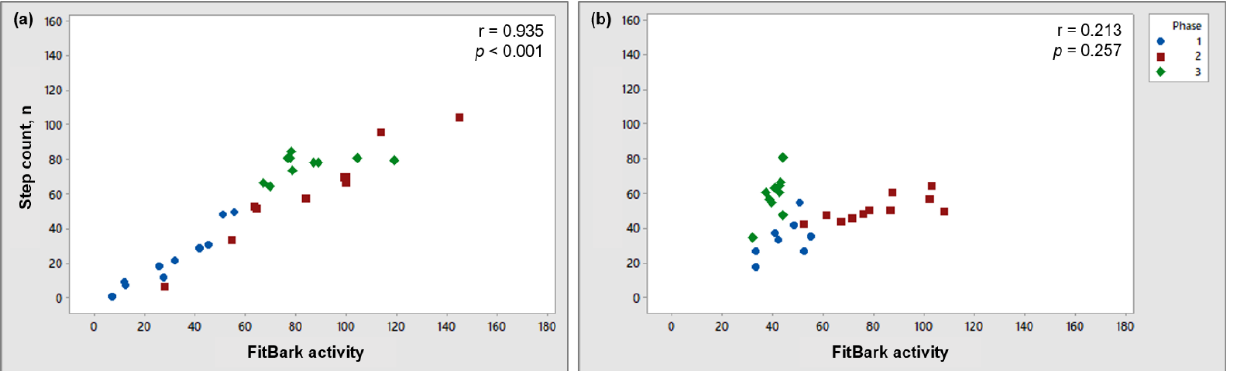
Figure 3. Plot showing the relationship between step count and activity recorded by a FitBark 2 monitor for Dog 25 (an example of a dog showing a very strong correlation; ( a ) and 19 (an example of a dog showing a negligible correlation; ( b ).